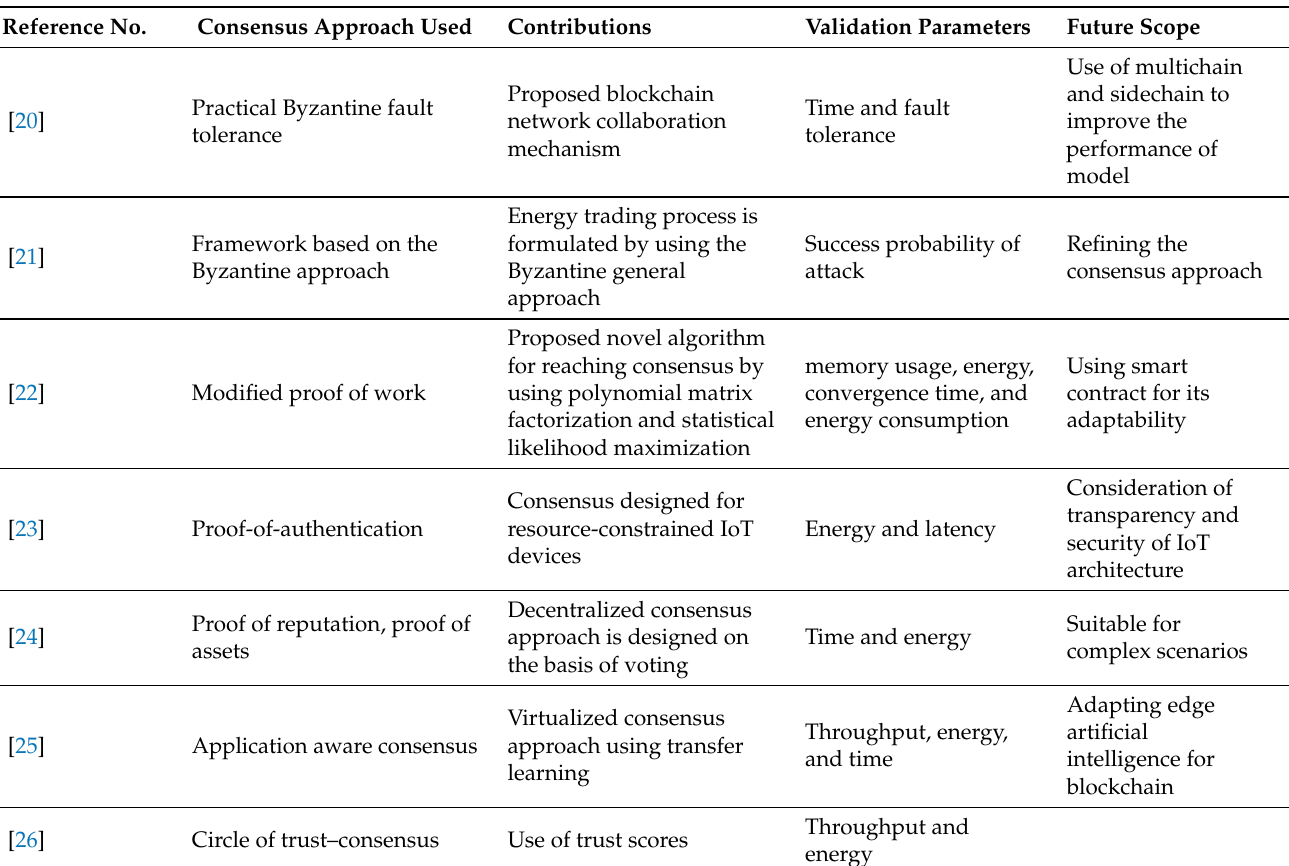
Table 1. Related works on the modification of consensus approach.